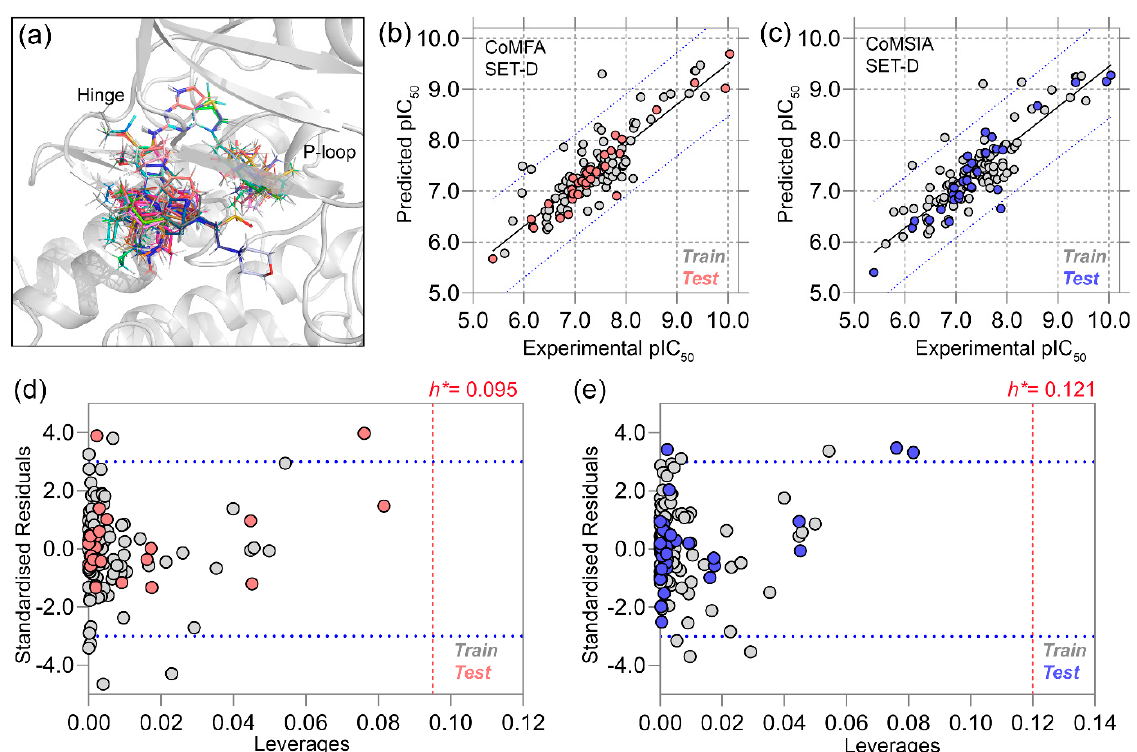
Figure 2. Molecular alignment of the dataset compounds, PLS plots, and applicability domain (AD) analysis. ( a ) Molecular alignment of the dataset compounds on the common chemical core by taking C36 inside the FAK binding cavity. ( b ) PLS correlation plots of the CoMFA (SET-D) study. ( c ) PLS correlation plots of the CoMSIA (SET-D) study. ( d , e ) Applicability domain analysis using the distance-based Williams plot using the data obtained from the CoMFA and CoMSIA models. The h* with dotted lines in red signifies the warning leverage values in both plots.